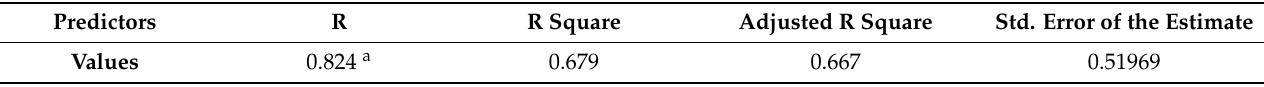
Table 5. Model summary of the regression analysis.